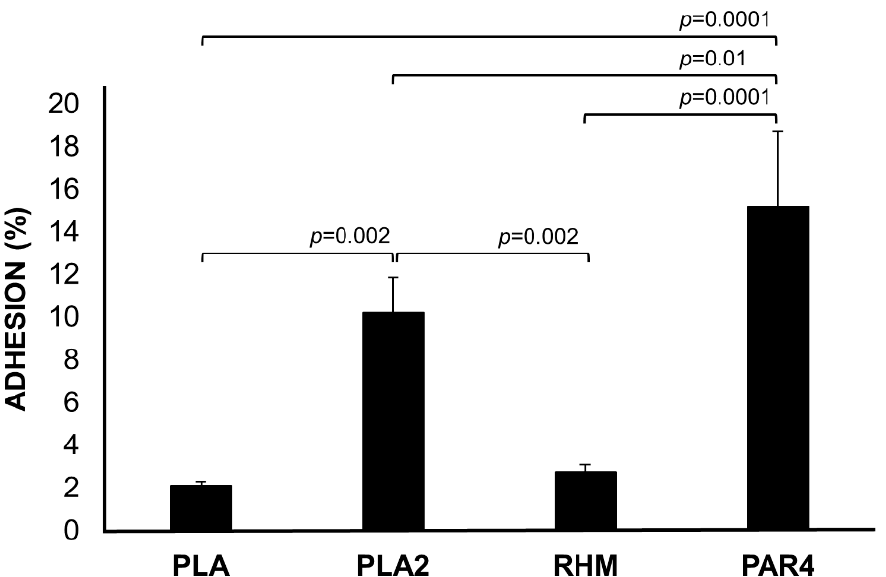
Figure 2. Adhesion of the lactobacilli strains to Caco-2 cell monolayers. The adhesion ability of L. plantarum PLA and PLA2, L. rhamnosus RHM and PAR4 was expressed as the percentage of adhesion. Statistical analyses were carried out by ANOVA test ( p < 0.05), followed by Fishers Least Significant Difference (LSD) test. Values represent the mean ± SD of three different experiments.